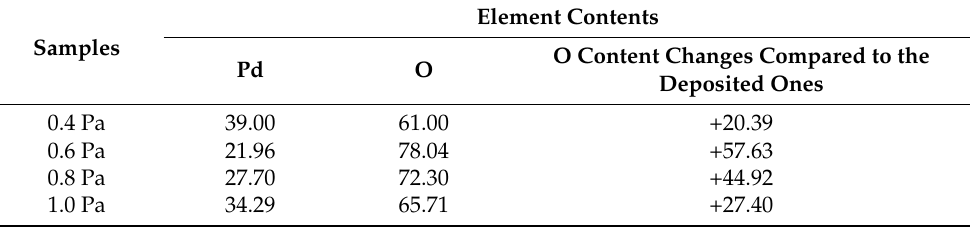
Figure 8. ( a – d ). EDS mapping of the pre-deposited Pd film deposited at different sputtering pressures after deuterium permeation: ( a ) 0.4 Pa, ( b ) 0.6 Pa, ( c ) 0.8 Pa and ( d ) 1.0 Pa. Table 3. Surface chemical composition of samples after the tests: the values are in atomic percent (at. %).